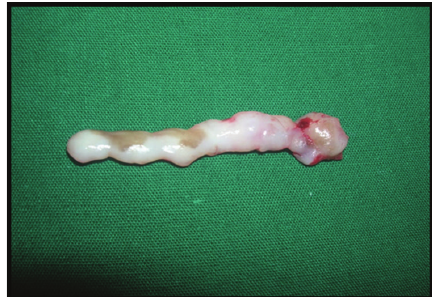
Figure 9: Postoperative view of male patient after six